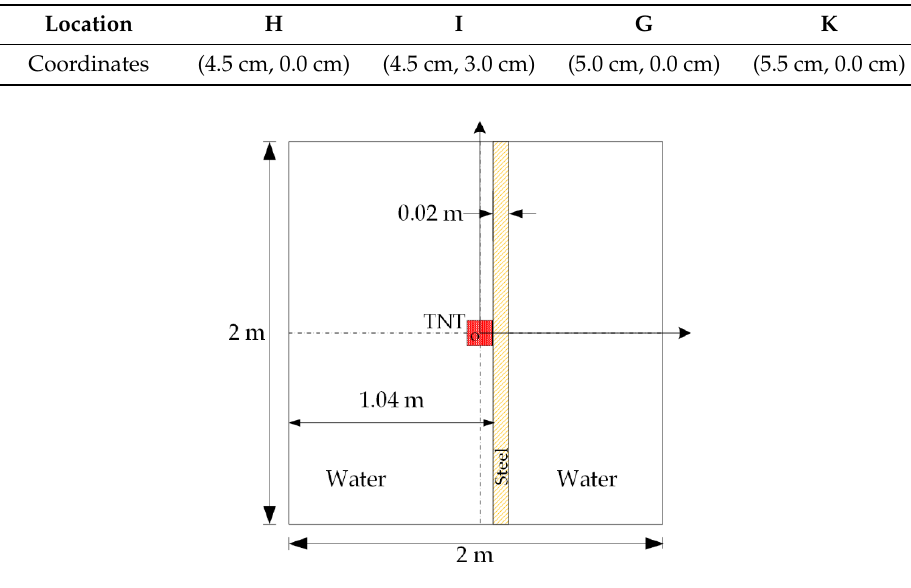
Figure 7. A thin plate subjected to explosive force.